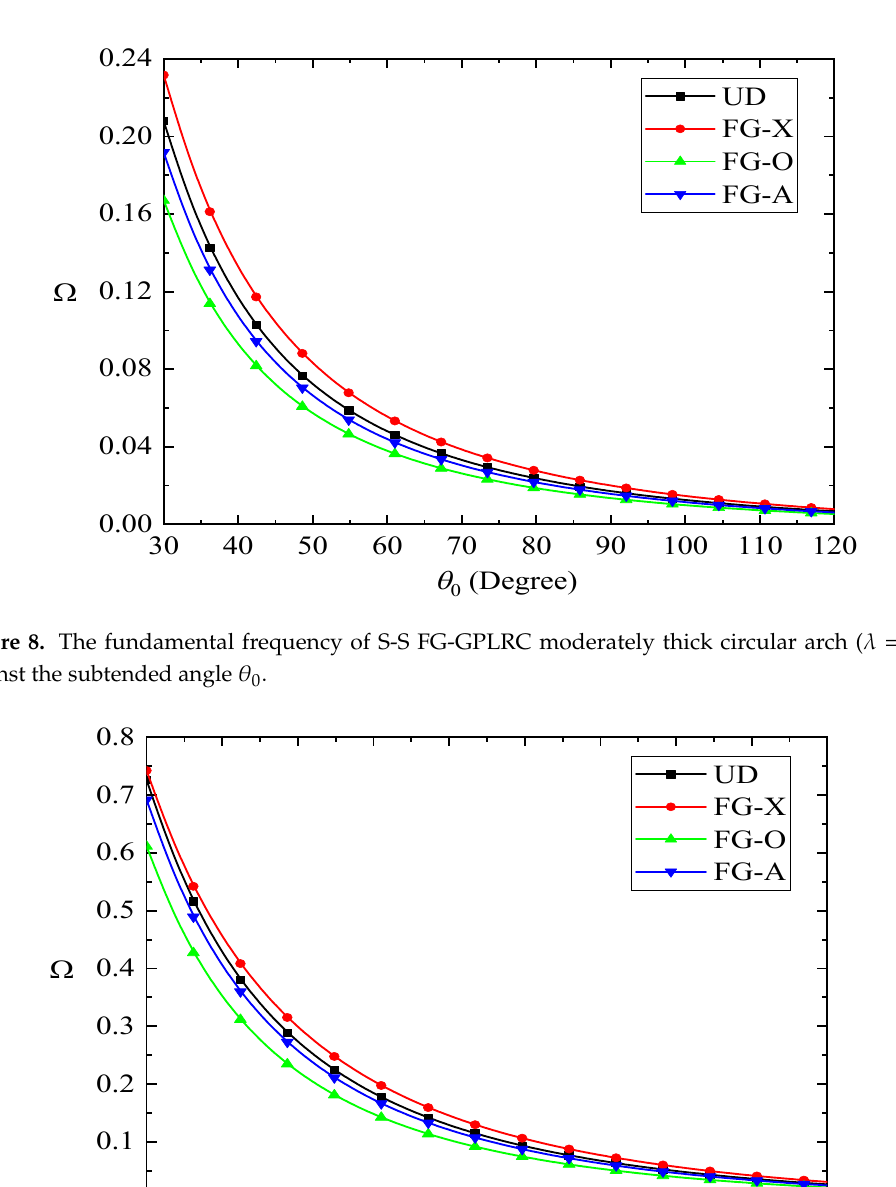
Figure 7. The fundamental frequency of S-S FG-GPLRC thin circular arch ( λ = 1/20) against the subtended angle θ 0 .